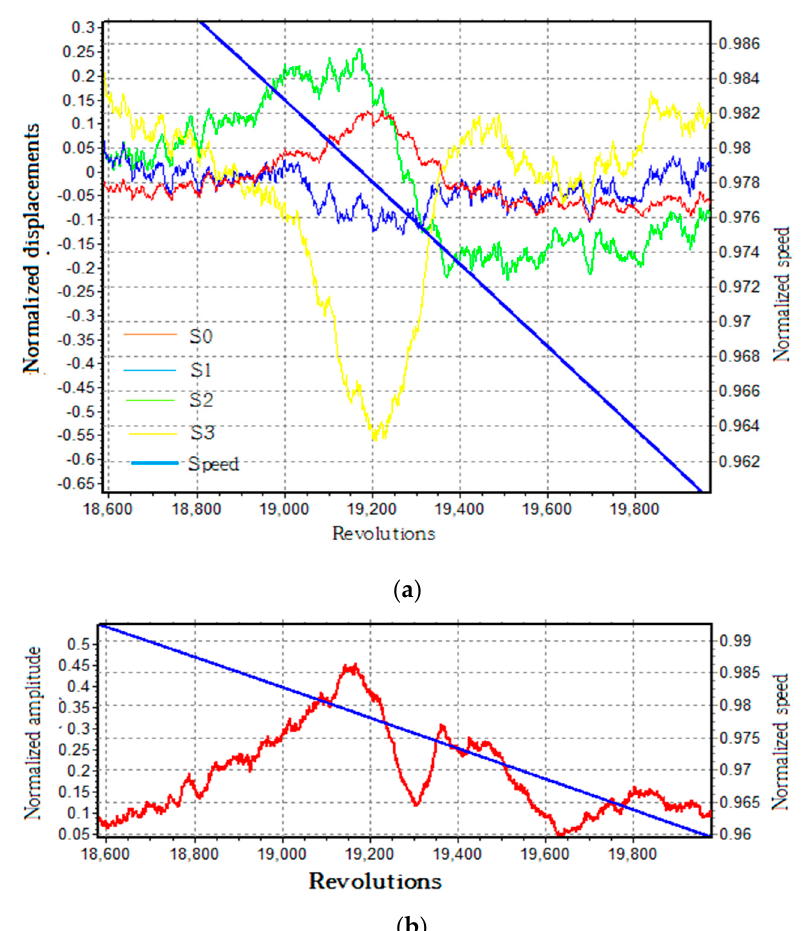
Figure 9. ( a ) Normalized displacements of all sensors (blade 22#). ( b ) Normalized amplitude results using the least squares fitting method.